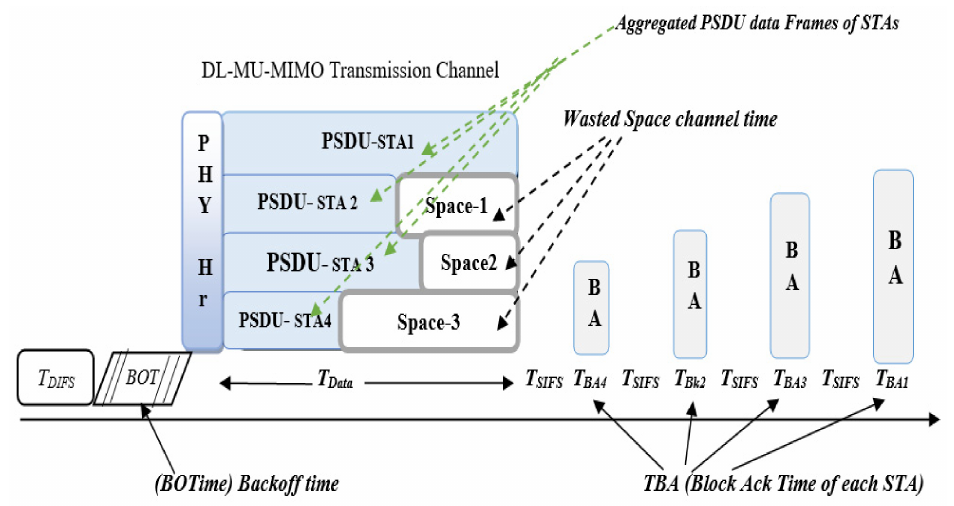
Figure 2. A diagram illustrates a single MU-MIMO transmission channel access for the case of 4 STAs. The AP performs all MU transmission considering the error-prone wireless